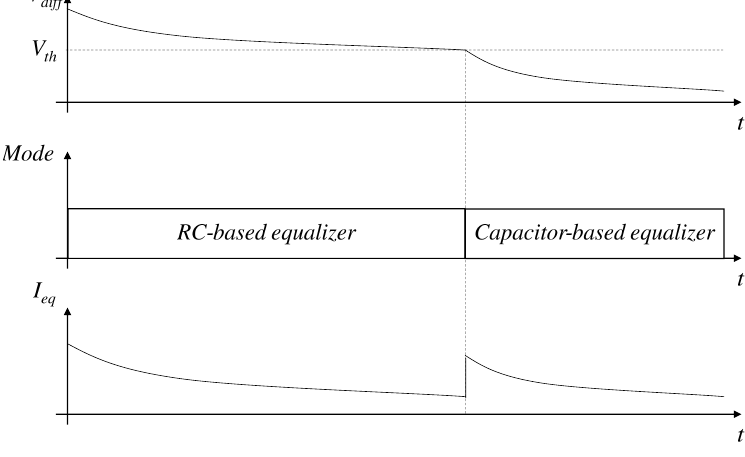
Figure 8. Functional diagram of operation for the proposed